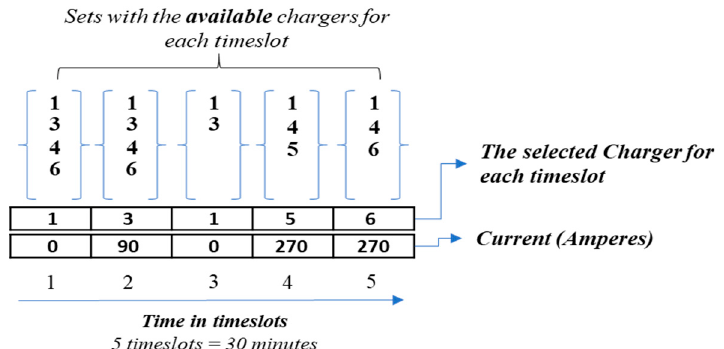
Figure 2. The formation of the charging alternative.